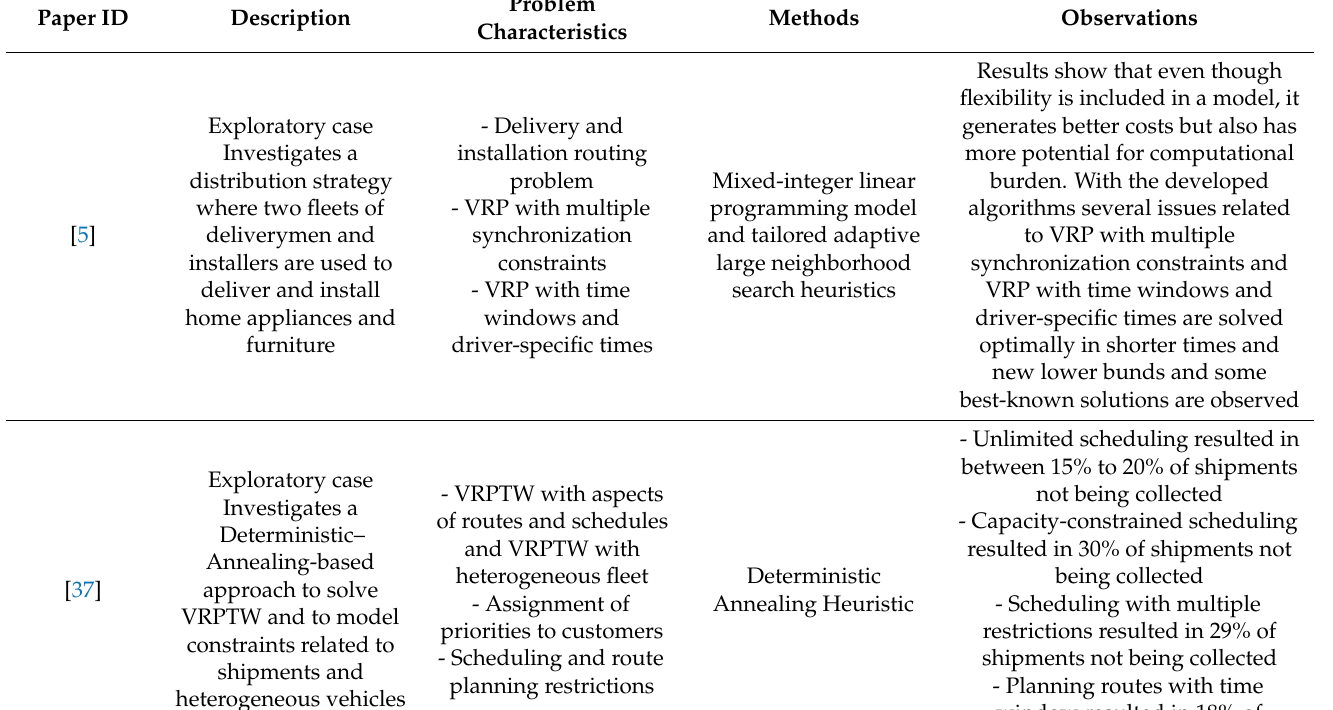
Table 1. Summary table of the papers with an application of heuristics to problems of deterministic route